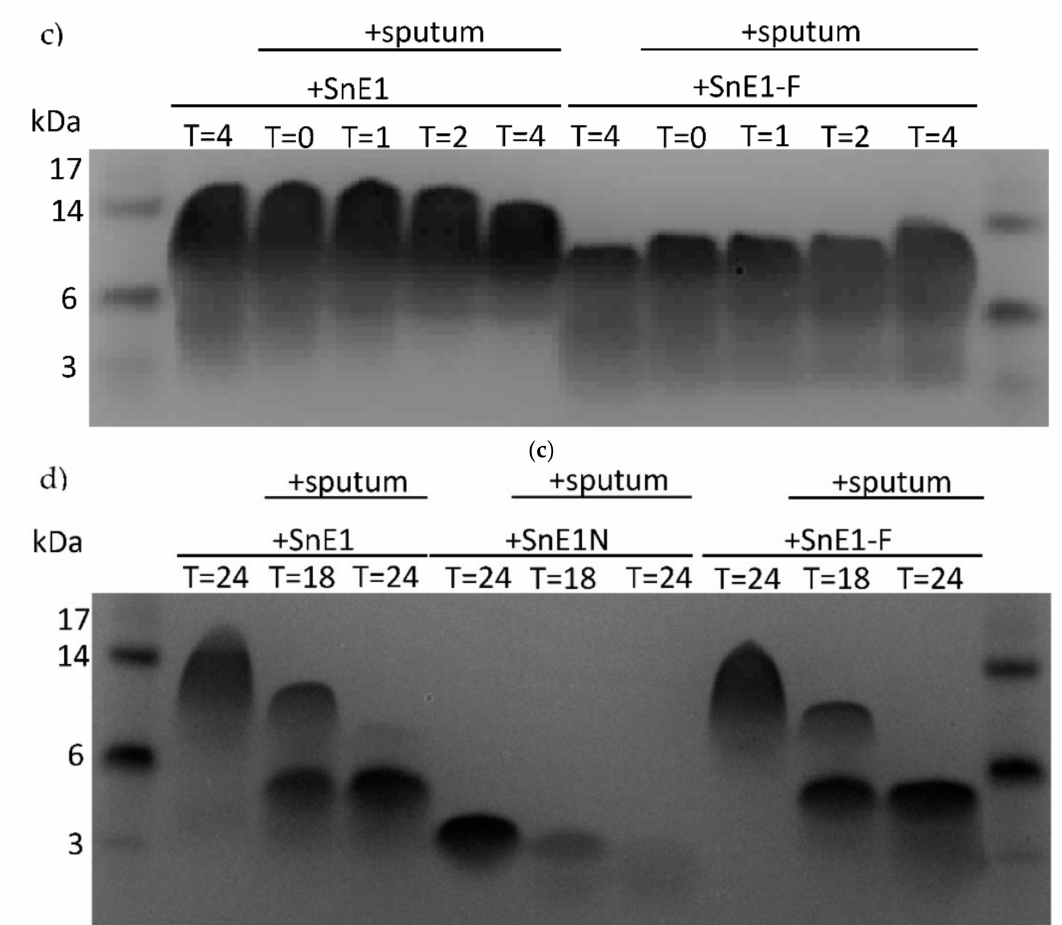
Figure 6. SDS-PAGE gels of next generation derivative peptides following incubation with CF sputum. An aliquot of ( a ) Sn1b, Sn1bN (160 µ M), ( b ) SnE1, SnE1N (120 µ M), ( c ) SnE1 and SnE1-F (120 µ M) were incubated with CF sputum for 0–4 h. ( d ) SnE1, SnE1N and SnE1-F (120 µ M) were incubated with CF sputum for 0–24 h. Samples were electrophoresed and stained with Coomassie stain for visual